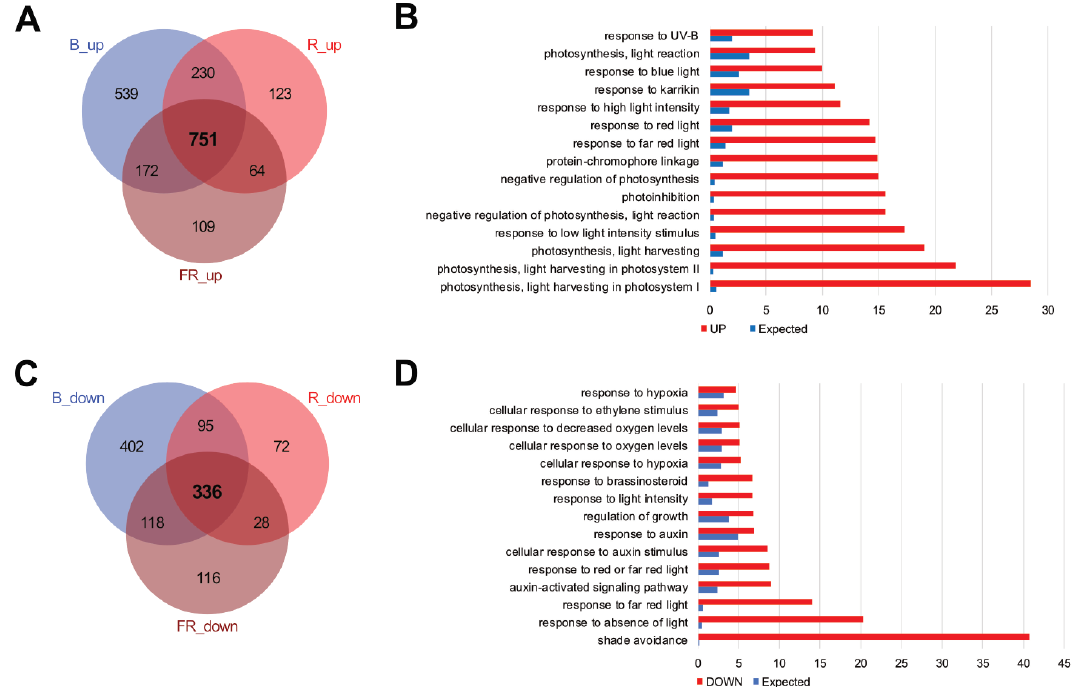
Figure 2. Comparison of differentially expressed genes (DEGs) in seedlings after the blue, red, and far-red monochromatic light irradiation. ( A ) and ( B ) Overlaps of up-regulated ( A ) and down-regulated ( B ) genes after the different monochromatic light irradiations. ( C ) and ( D ) Gene ontology (GO) term enrichments of up-regulated ( C ) or down-regulated ( D ) genes after the different monochromatic light irradiations. DEGs were derived from either 1h or 3h light exposures in RNA-seq analysis.